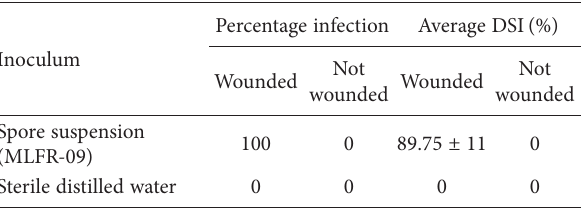
Table 3. Pathogenicity test and disease severity index (DSI) of caused by Fusarium annulatum isolate MLFR-09 on Cucumis melo var. cantalupensis